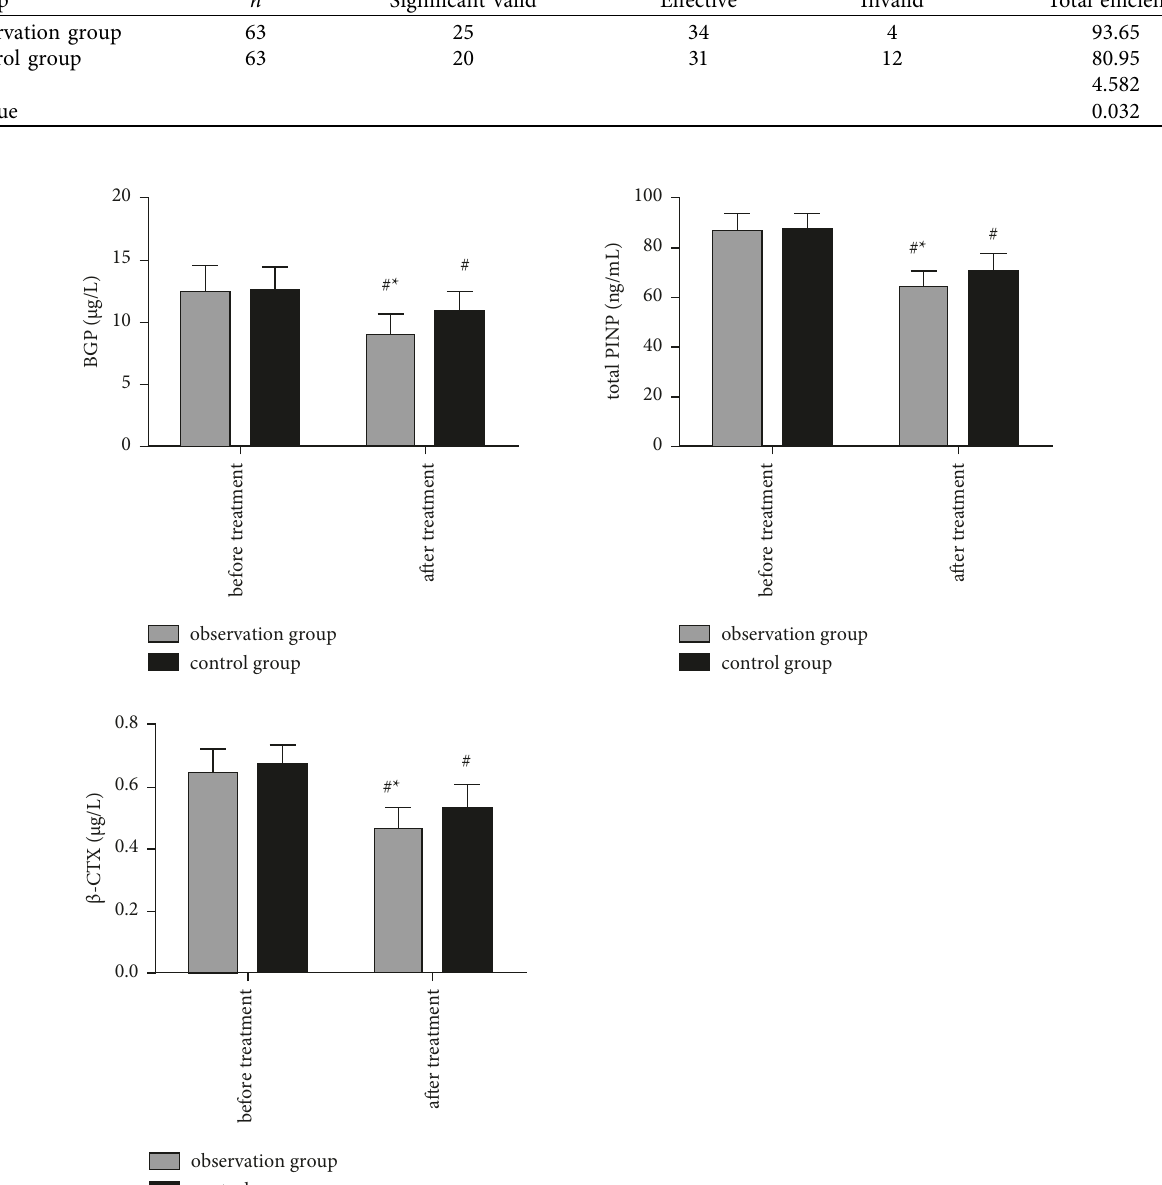
Table 1: Comparison of therapeutic efficacy between groups with/without prebiotics/probiotics preparations ( n , (%)). Group n